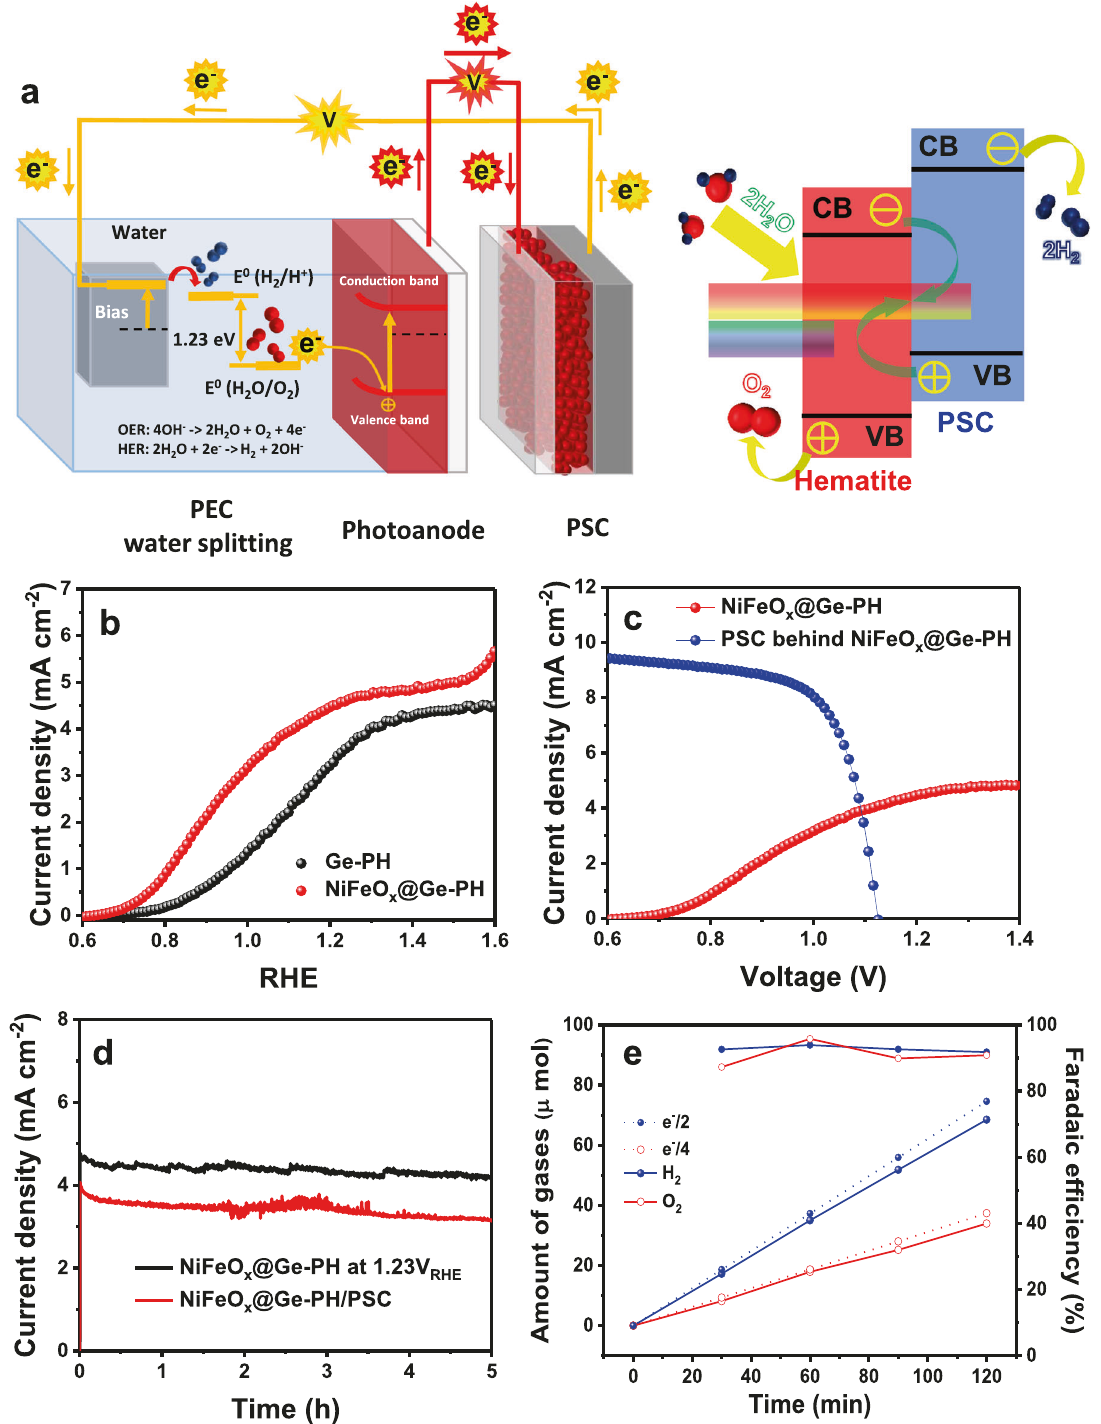
Fig. 5 NiFeO x @Ge-PH/PSC solar water splitting ef fi ciency. a Schematic of the tandem system featuring a perovskite solar cell (PSC) and photoanode with a Z-scheme of arti fi cial photosynthesis driven by light absorption (left). Hematite was used to evolve oxygen and the PSC was used to evolve hydrogen (right). b J-V curves of Ge-PH and NiFeO x decorated Ge-PH. c J-V curves of a PSC-hematite-based photoanode tandem device together. d Stability of the NiFeO x @Ge-PH at 1.23V RHE and NiFeO x @Ge-PH/PSC solar water splitting. e Faradaic ef fi ciency of the NiFeO x